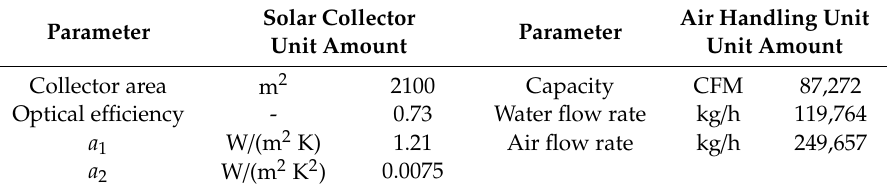
Table 3. The absorption chiller specifications.